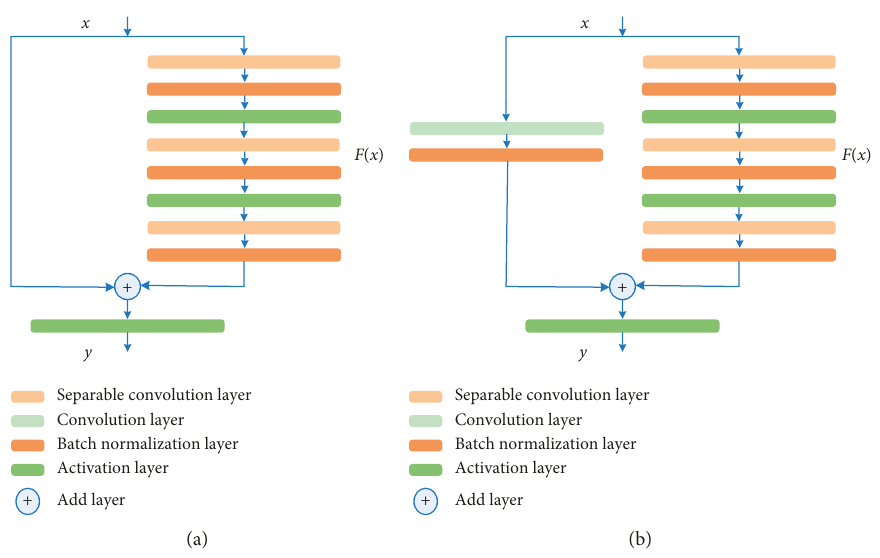
Figure 3: Two types of blocks. (a) ap_block. (b)